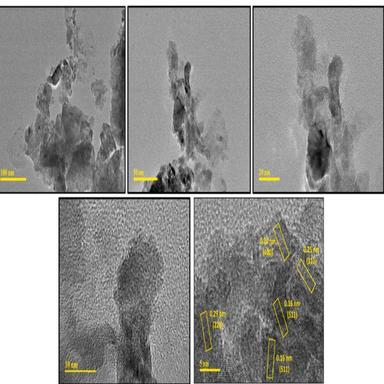
TEM and HR-TEM micrographs of NCZFe2-4xSn3xO4 (x = 0.04) NSFs.